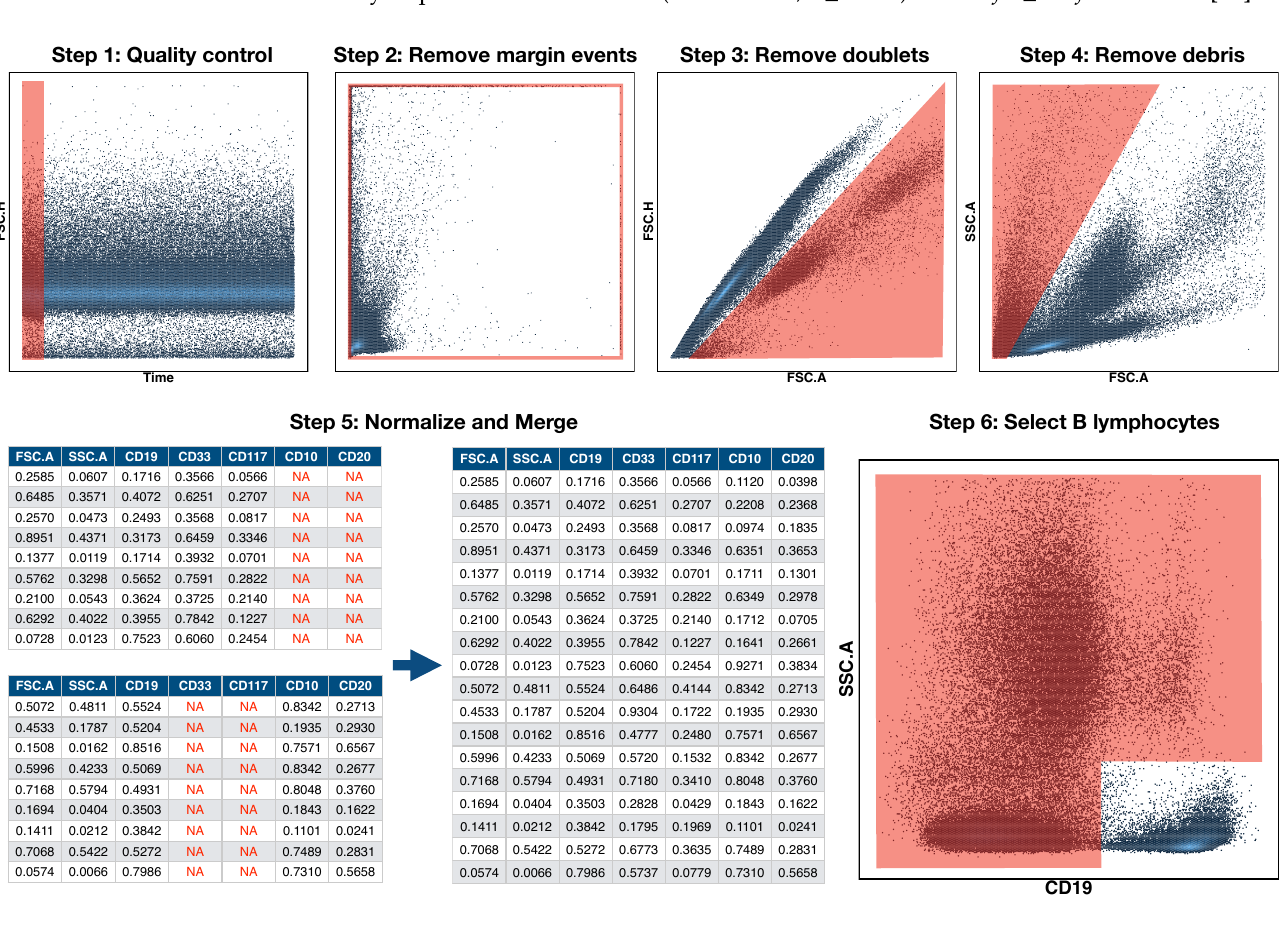
Figure 1. Preprocessing pipeline of Flow Cytometry Files. Preprocessing was carried out in six steps. The first four were performed in FlowJo and they consisted in the removal of abnormal acquisitions (quality control), margin events, doublets, and debris. The files were then imported into R in step 5 and, for each patient, all tubes or aliquots were merged into a single file by means of nearest-neighbour imputation. Finally, in step 6, the CD19 + population (B cells) was automatically selected for further